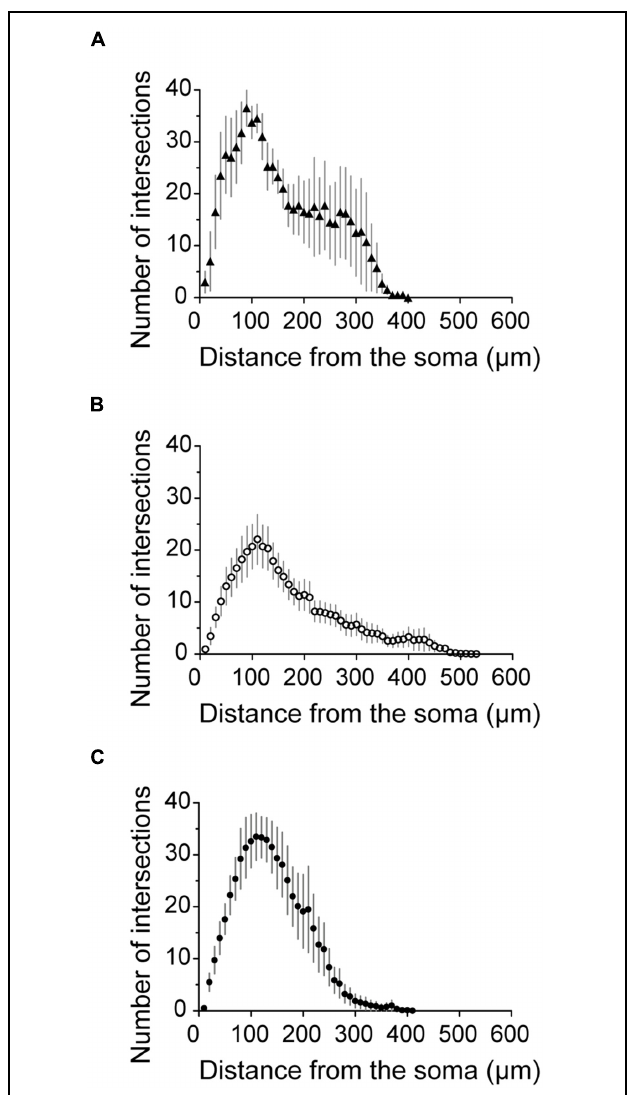
FIGURE 8 | Axonal Sholl plots. (A–C) Sholl plots of the number of axon crossings for concentric circles against distance from the soma for neurons from cluster 1 ( A , filled triangles, n = 4), cluster 2 ( B , empty circles, n = 13) and cluster 3 ( C , filled circles, n = 8). Error bars indicate mean ±